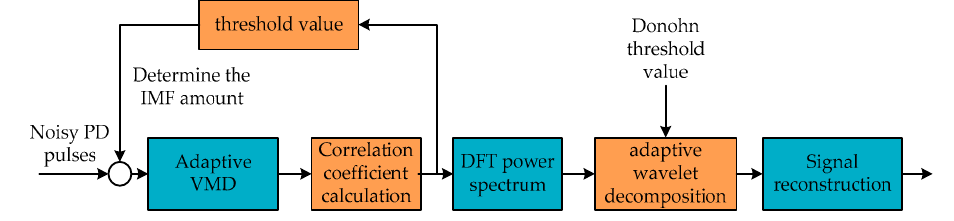
Figure 7. The overall flow of the proposed de-noising method.